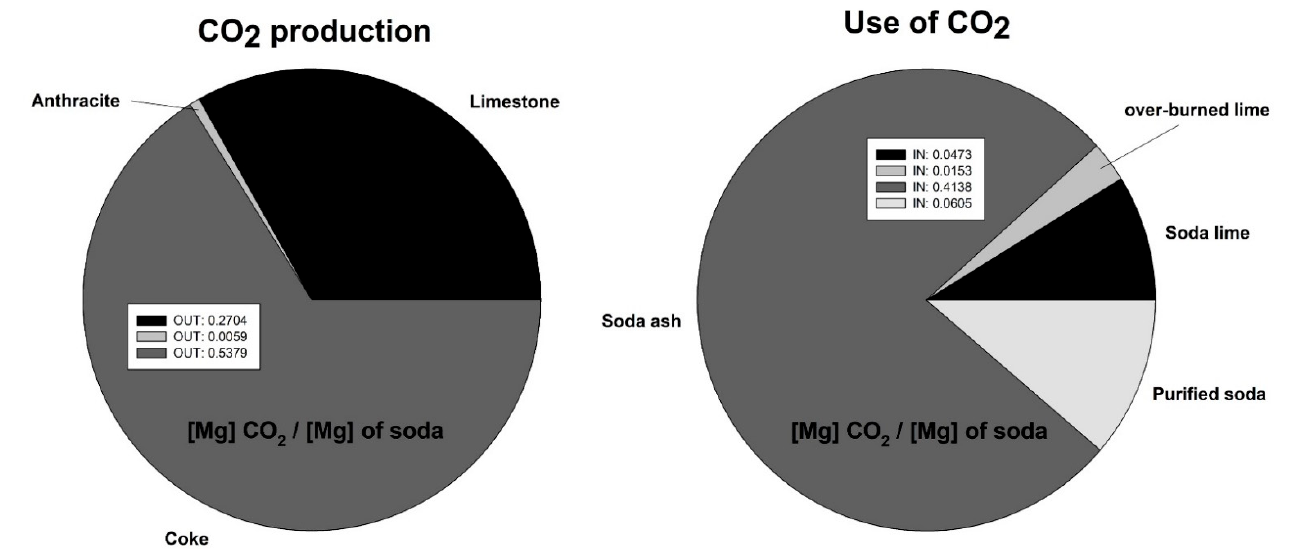
Figure 20. Production and use of CO 2 in Inowroclaw factory for soda ash process. Global soda ash production in 2021 was 59 Tg, of which 17 Tg was mine production and 42 Tg was typical Solvay process production. The output of the others is negligible.